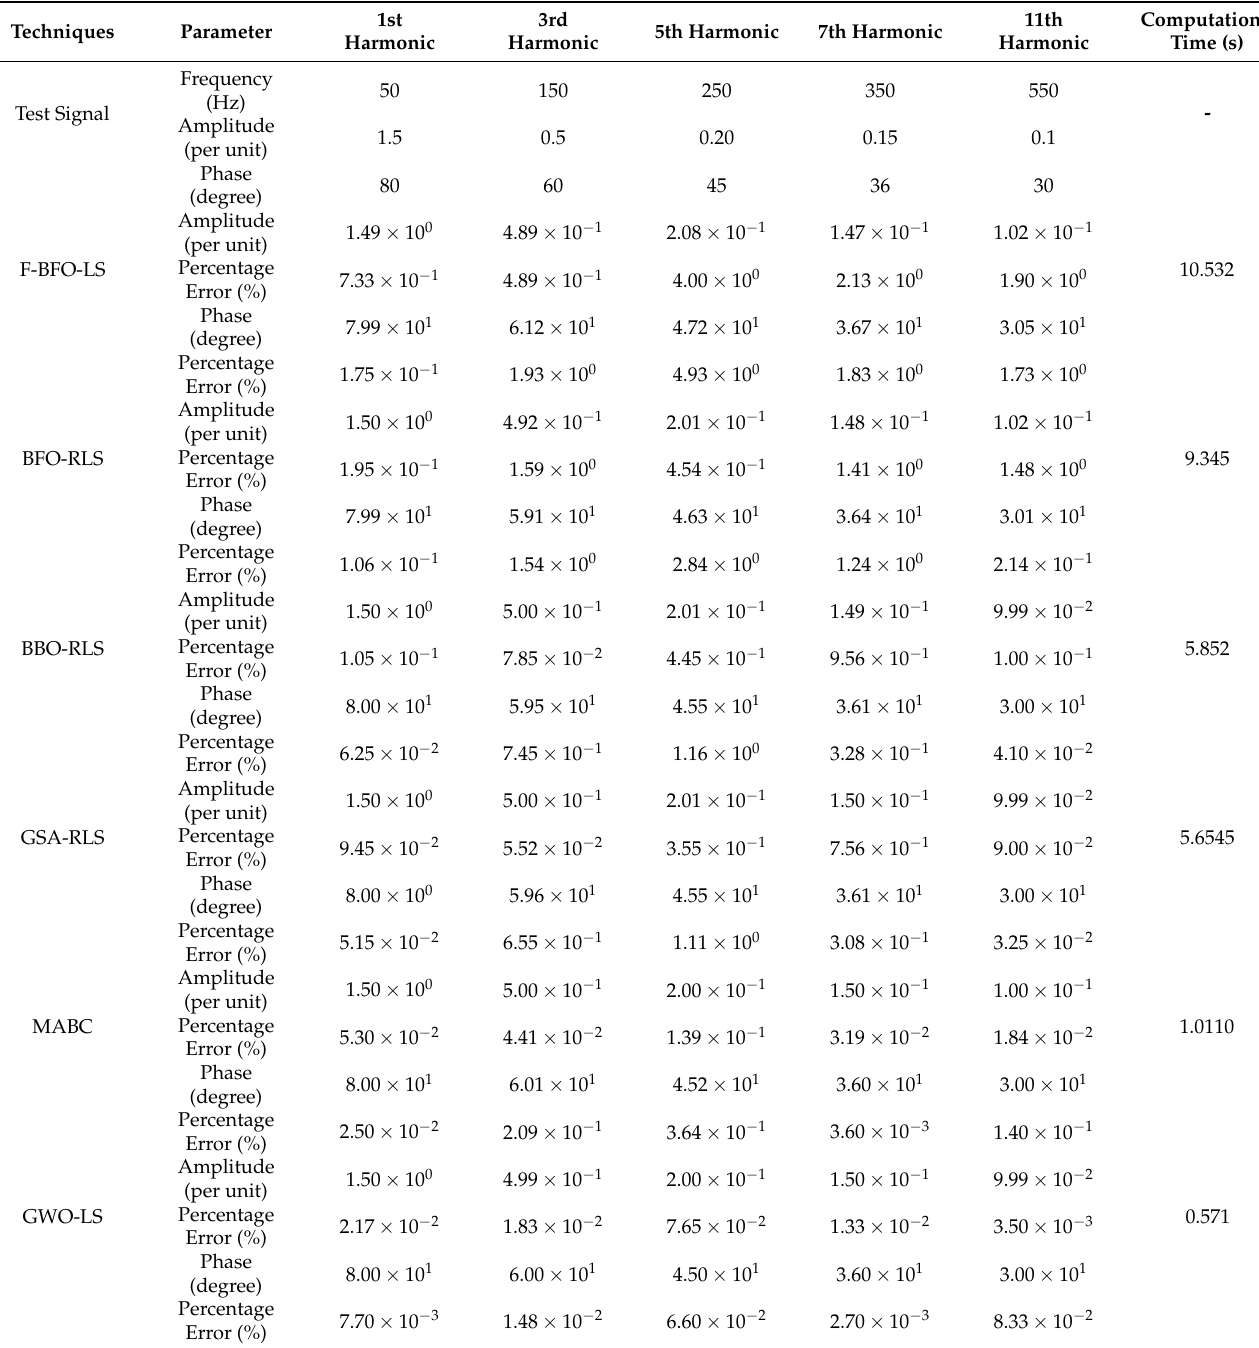
Table 5. GWO-LS Numerical Comparison for Case Study